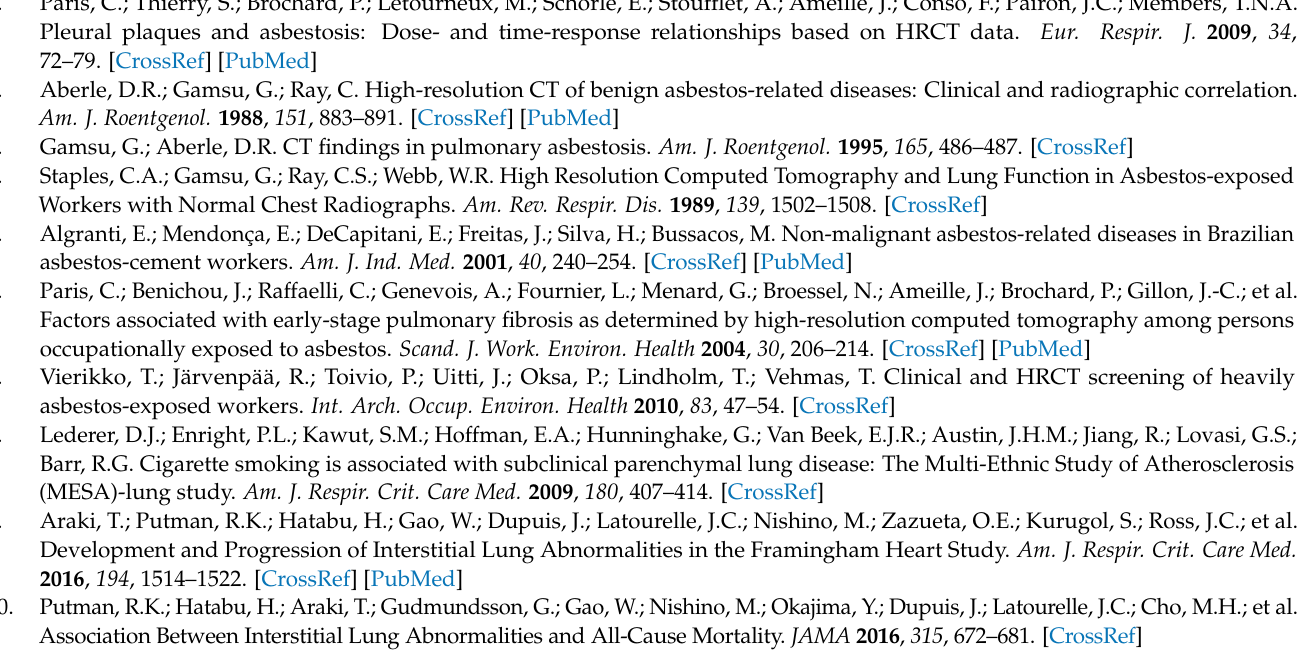
Table S3: Most represented occupations (ISCO 68) in the general population ( n = 2157) and according interstitial abnormalities detected at CT. Table S4: Most represented industries (ISIC Rev 2) in all subjects and according interstitial abnormalities detected at